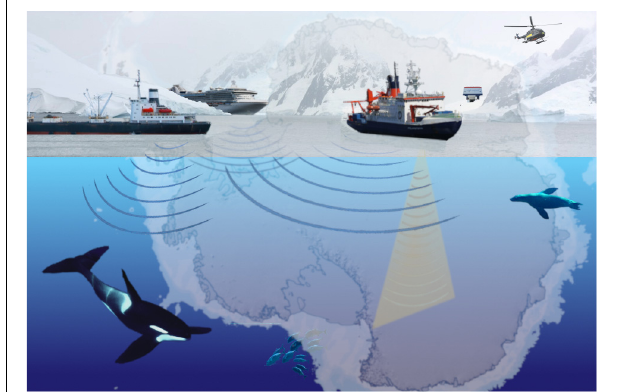
FIGURE 1 | Sketch of sources of underwater noise in the Antarctic. All vessels (fishing vessels, cruise ships, research vessels, etc.) produce underwater noise in a nearly omni-directional pattern (indicated by circular sound wavefronts). Ships use echosounders that scan the sea floor with a narrow swatch of sound (indicated in yellow). Research station infrastructure and support includes construction activities, vessels as well as aircraft—all of which may be detected under